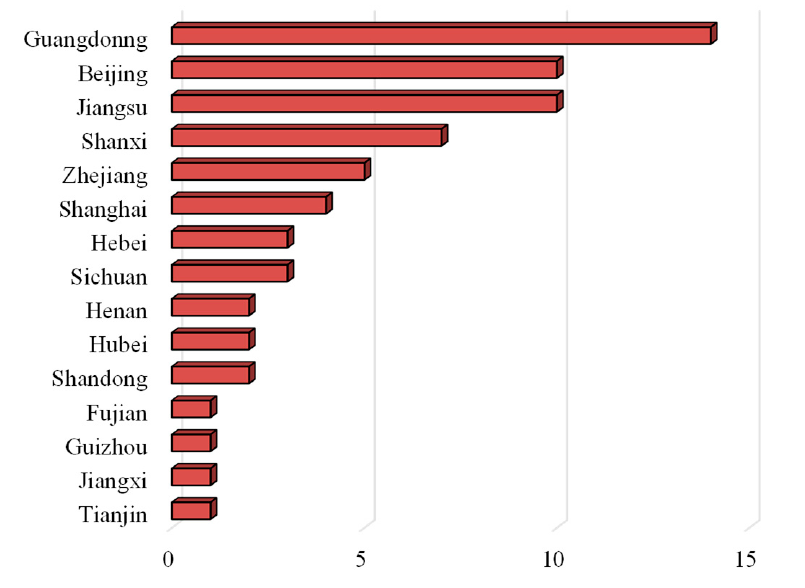
Figure 4. Geographical distribution of LVDC buildings.